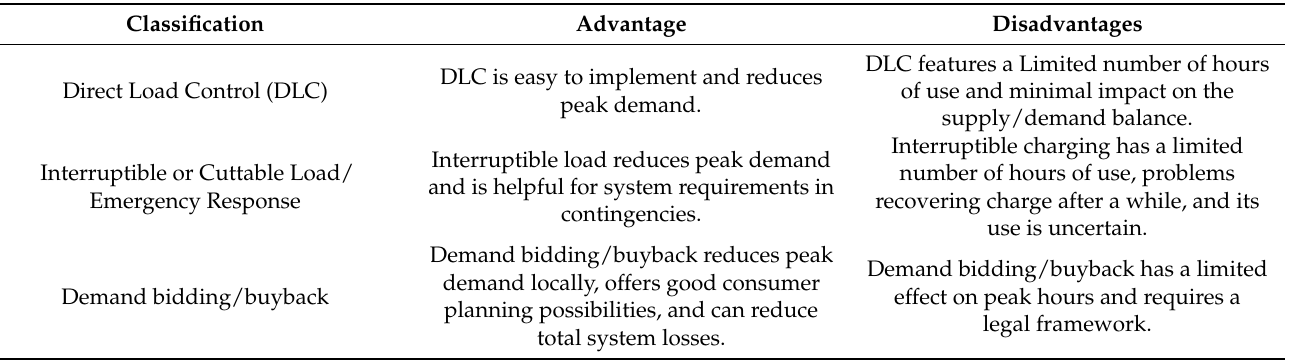
Table 2. Incentive-based